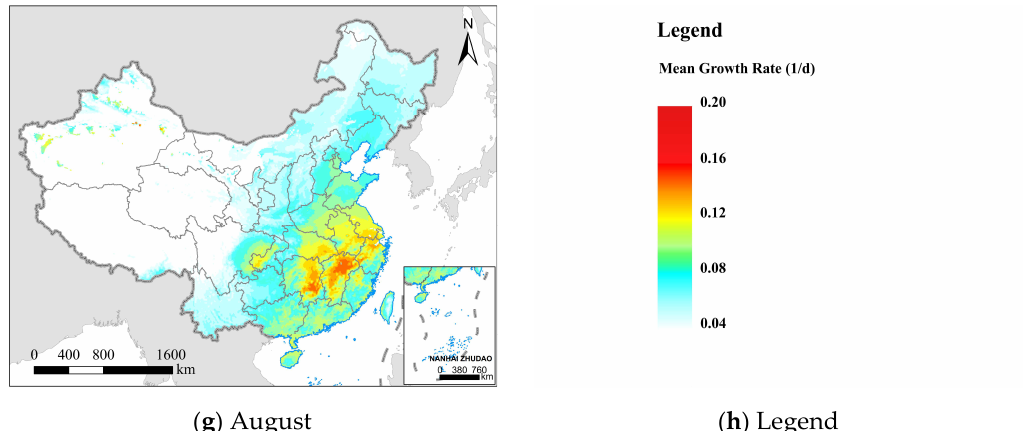
Figure 8. The mean daily growth rate (environmental suitability) of FAW from February to August 2020; ( a – g ) represent different months; the white areas represent areas that are not suitable for FAW; and ( h ) the legend from blue to red represents increased growth rate and environmental suitability.